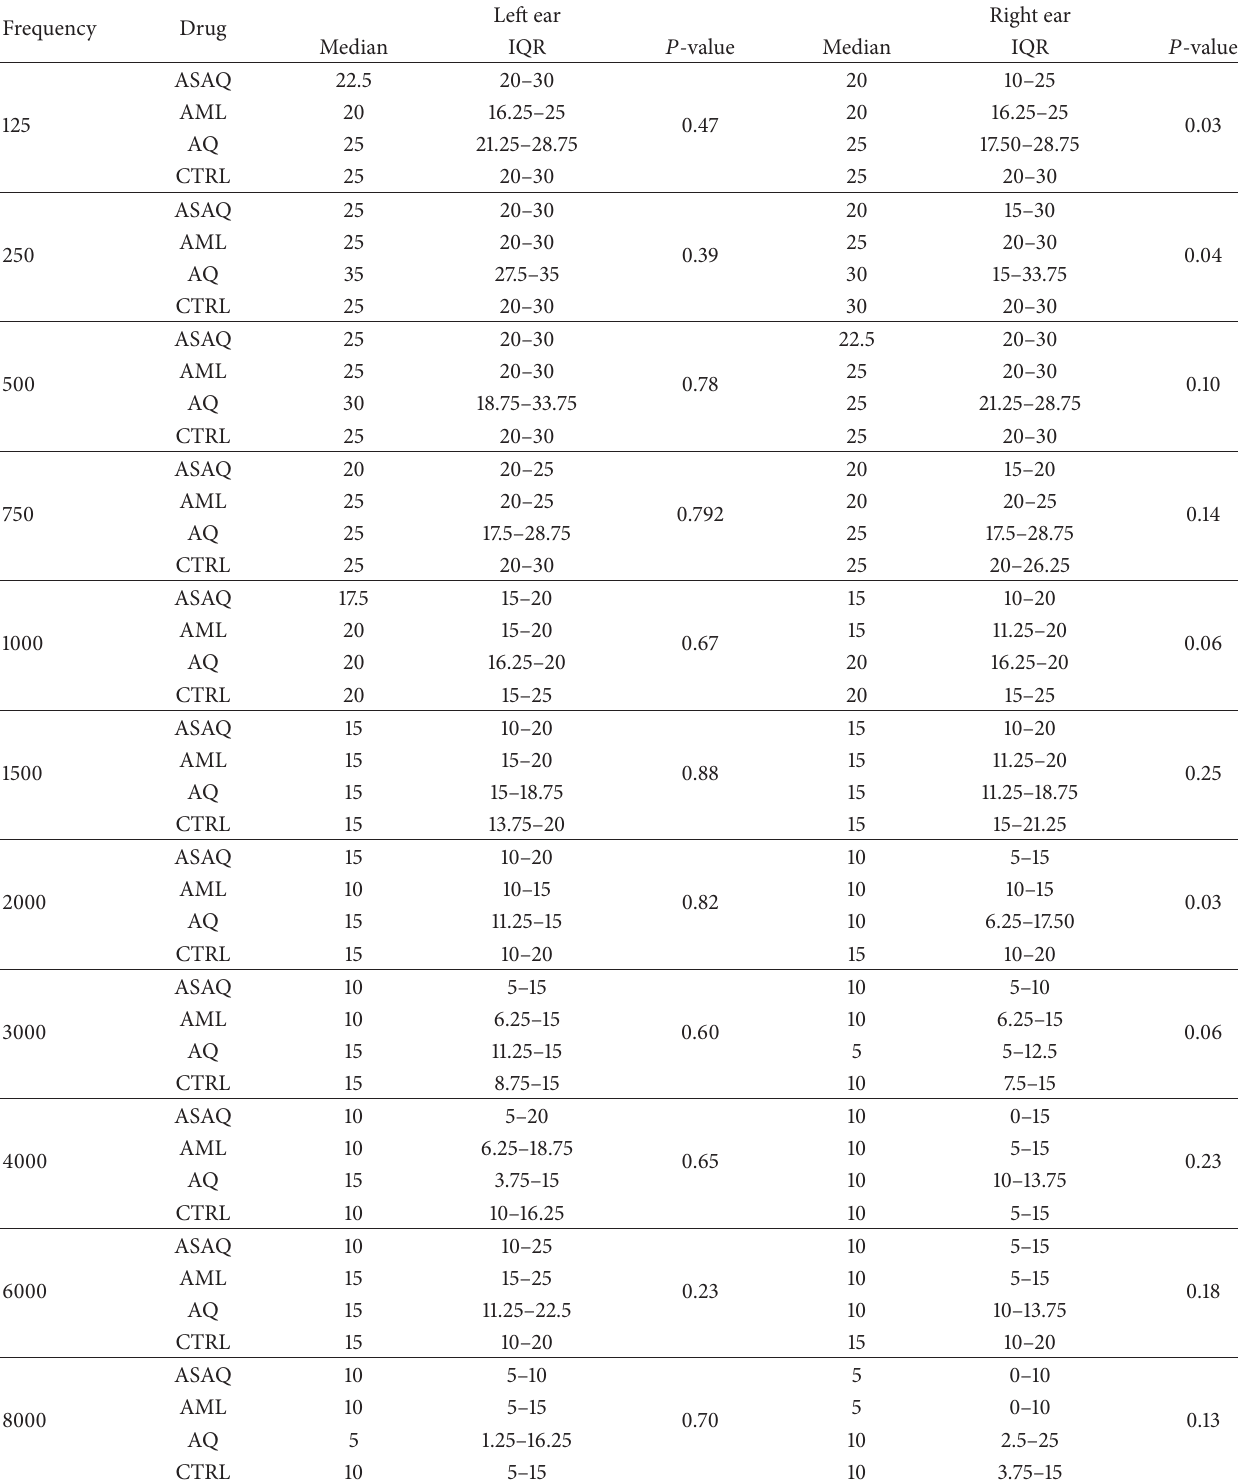
Table 2: Median hearing threshold levels after 9–12